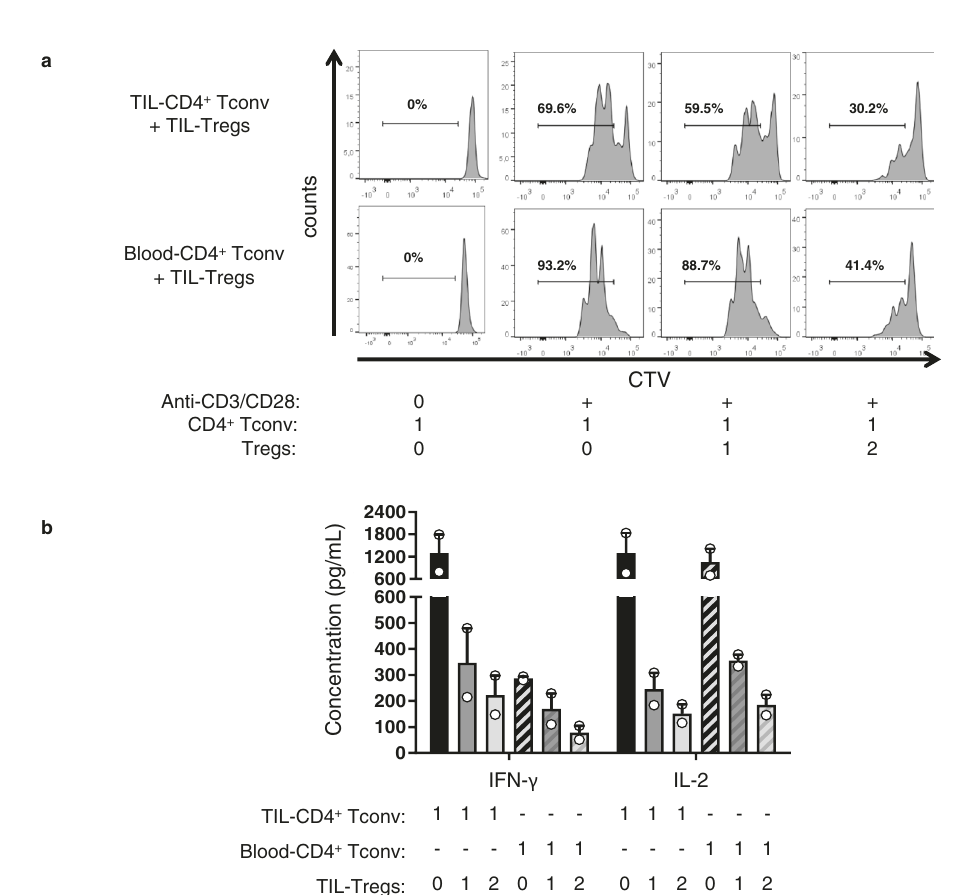
Fig. 6 TIL-Tregs have a strong capacity of suppressing CD4 + Tconv proliferation ex vivo. a Sorted CD2 + CD8 - CD4 + CD127 + Tconv stained with cell trace violet (CTV) were cultured with or without sorted CD2 + CD8 - CD4 + CD25 bright CD127 - Tregs for 72 hours at different ratios Tregs:CD4 + Tconv (0:1, 1:1 and 2:1) in presence of anti-CD3/anti-CD28 coated beads (1 bead/10 cells). Proliferation of CD4 + Tconv was measured by analyzing CTV dilution during cell culture. Representative data of one out of fi ve experiments. b IFN- γ and IL2 secretion secreted by CD4 + Tconv previously sorted from tumors or blood of NSCLC patients and cultured with anti-CD3/anti-CD28 coated beads with or without autologous TIL-Tregs. The histograms represent the mean values + / − SEM of cytokine production of two independent